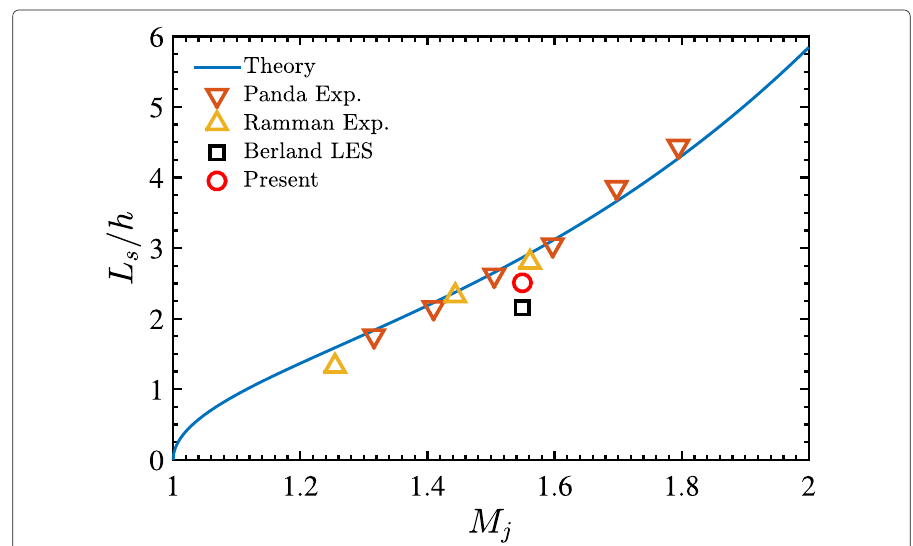
Fig. 18 Shock-cell spacing L h / h as a function of the fully expanded jet Mach number M j . Our result is more close to theoretical [17] and experimental results [18, 19], compared to the LES results of Berland et al. [16]